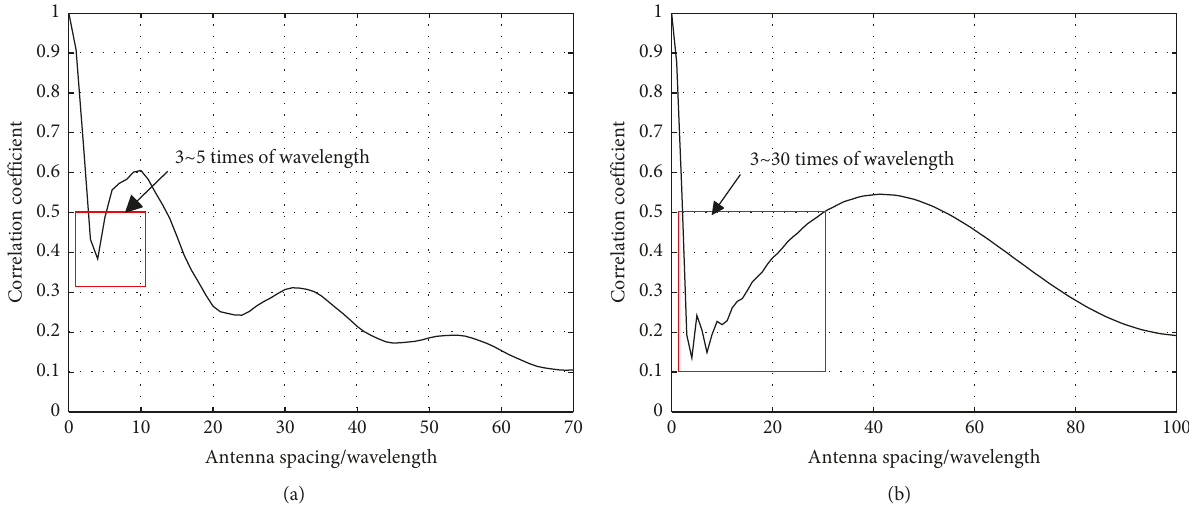
Figure 9: Correlation coefficient. (a) Rx antenna elements: ASA � 4.15 ° ; ESA � 9.71 ° . (b) Tx antenna elements: ASD � 4.64 ° ; ESD � 0.92 °